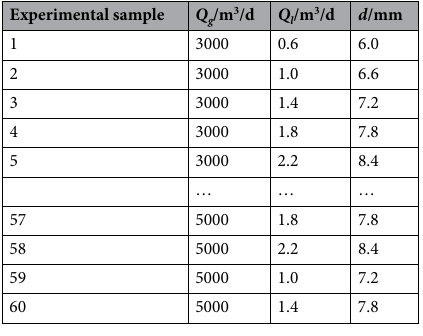
Table 2. Orthogonal experiment sequence table.